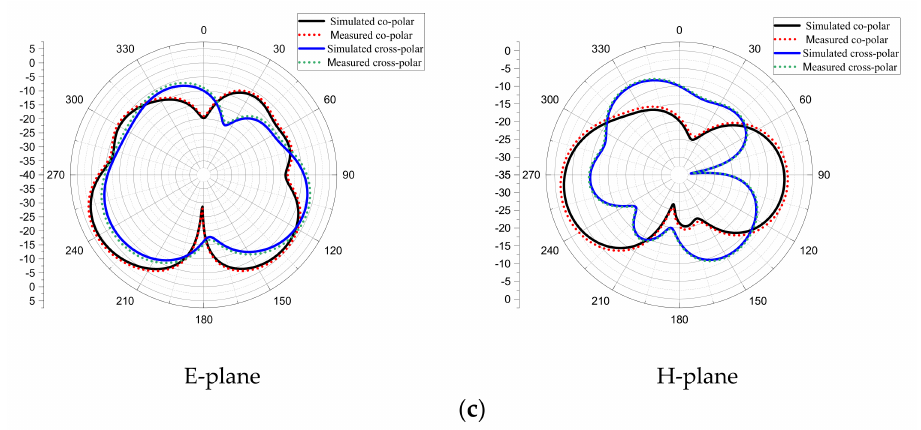
Figure 14. Measured and simulated co-polar and cross-polar 2D radiation patterns in both E-plane and H-plane of the designed Sierpinski hexagonal-shaped fractal antenna at ( a ) 2.4 GHz; ( b ) 6.6 GHz; ( c ) 9.8 GHz.